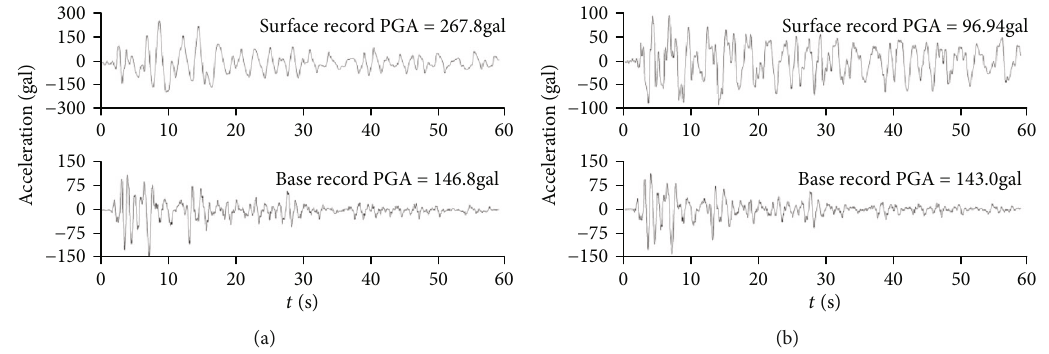
Figure 4: Acceleration time history response of EL – 3 situation: (a) model 1 and (b) model 2.